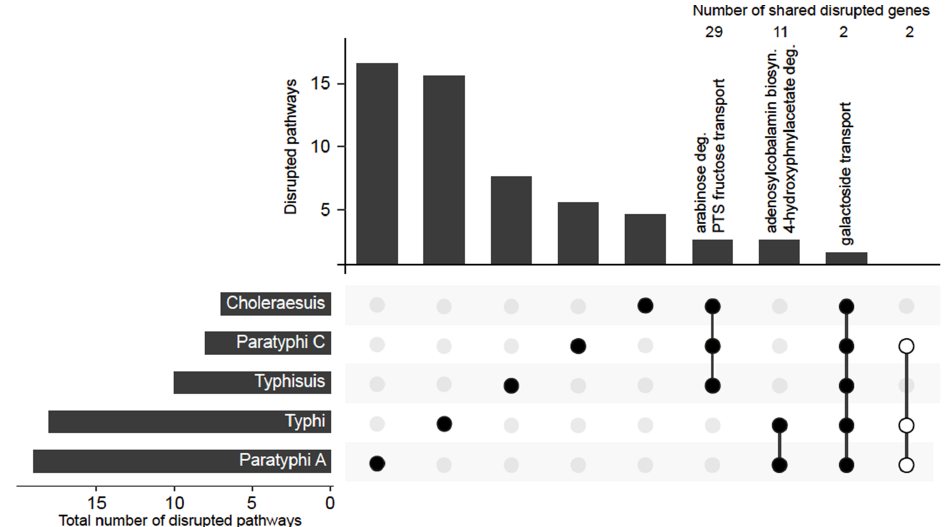
Figure 3. Distribution of disrupted pathways. Annotated UpSet plot of shared and unique disrupted pathways. Number of genes disrupted in pathways given above the columns (includes multiple genes disrupted in same pathway). Open circles: no disrupted pathways are shared between S. Typhi, S. Paratyphi A and S. Paratyphi C.